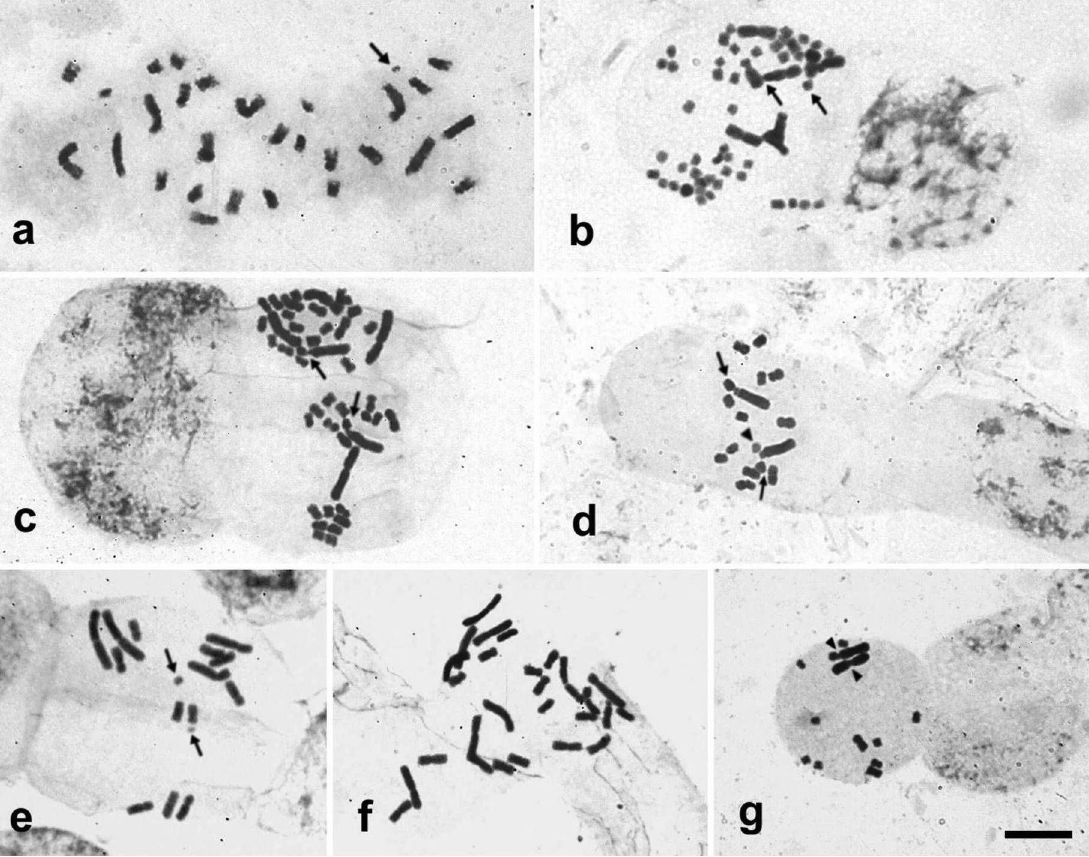
Figure 1 - Mitotic metaphase and interphase nuclei of species of the Tribe Tigrideae from northeastern Brazil : (a-d) Alophia drummondii with (a) 2 n = 28 and one visible satellite; (b) 2 n = 56 and two satellites and (c) 2 n = 42 and one satellited pair; (d) 2 n = 14+1B with a pair of distended satellites and a heteropicnotic B chromosome (arrowhead); (e) Cipura paludosa with 2 n = 14 and a pair of distended satellites; (f) Cipura xanthomelas with 2 n = 28; (g) Eleutherine bulbosa (2 n = 12) with a distended secondary constriction (arrowhead). Arrows indicate satellites in (a), (b), (c), (d) and (e). The bar corre- sponds to 10 (cid:2)